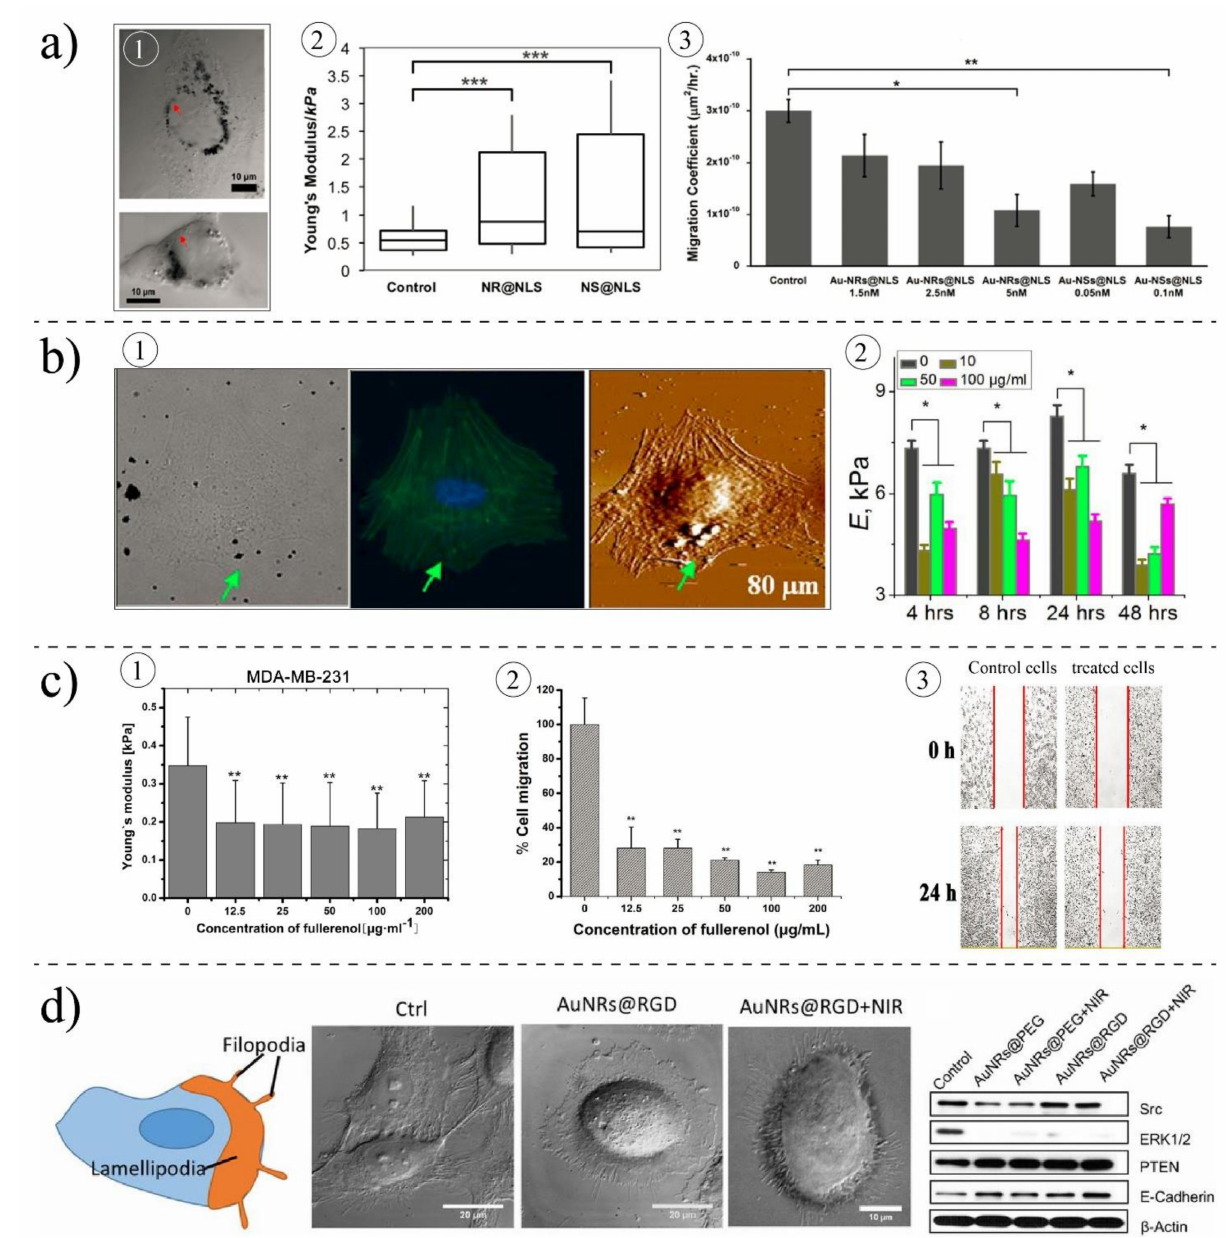
Figure 8. Effects of NPs on cell mechanics. ( a ) Effects of gold nanospheres (NS) and nanorods (NR) on HEYA8 cell, ( a1 ) TEM images of cells treated with NPs, ( a2 ) treated cells are become stiffer compared to control cells, ( a3 ) effects of NPs on the migration ability of cells. Reprinted with permission from [172]. Copyright American Chemical Society 2017. ( b ) Effects of DEPs on HAECs cells, ( b1 ) bright field, fluorescent, and AFM images of cells treated with NPs and their distribution in cells, ( b2 ) elasticity (E) of treated cells compared to control cells after different exposure times (* p < 0.01) [161]. Copyright 2012, Open Access, PloS ONE Journal. ( c ) Effects of small fullerenol on human breast cancer cells, ( c1 ) elasticity of MDA-MB-231 cells is reduced upon interaction with NPs, ( c2 ) migration ability of cells is reduced, ( c3 ) scratch assay measurement for treated cells and control cells [151]. Copyright 2018, Open Access, Nanobiotechnology Journal. ( d ) Effects of gold nanorods on HSC. NPs could change the morphology of cells and reduce the movement ability of cells by changing the protein expression. Reprinted with permission from [158]. Copyright (2017) National Academy of